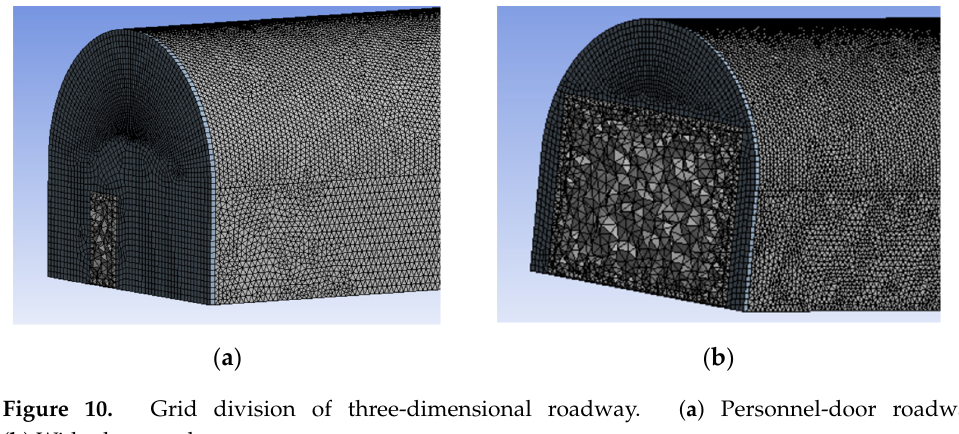
Figure 10. Grid division of three-dimensional roadway. ( a ) Personnel-door roadway; ( b ) Wide-door roadway.